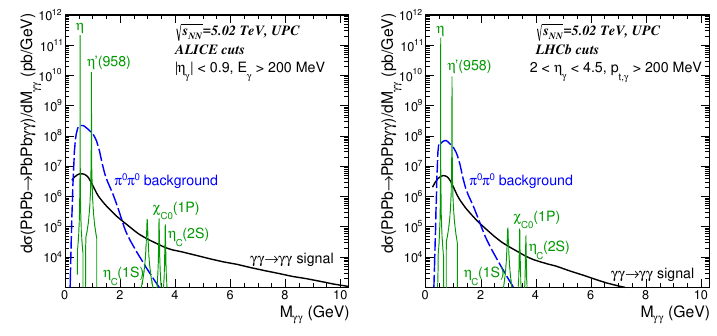
Figure 2. Diphoton invariant mass distribution for kinematical cuts which are given in the figure: left panel is for ALICE experiment and right panel corresponds to LHCb experiment. The black solid lines are the signal due to Standard Model box contribution, the blue dashed lines correspond to the π 0 π 0 background, while solid green lines are for resonant mesonic states.